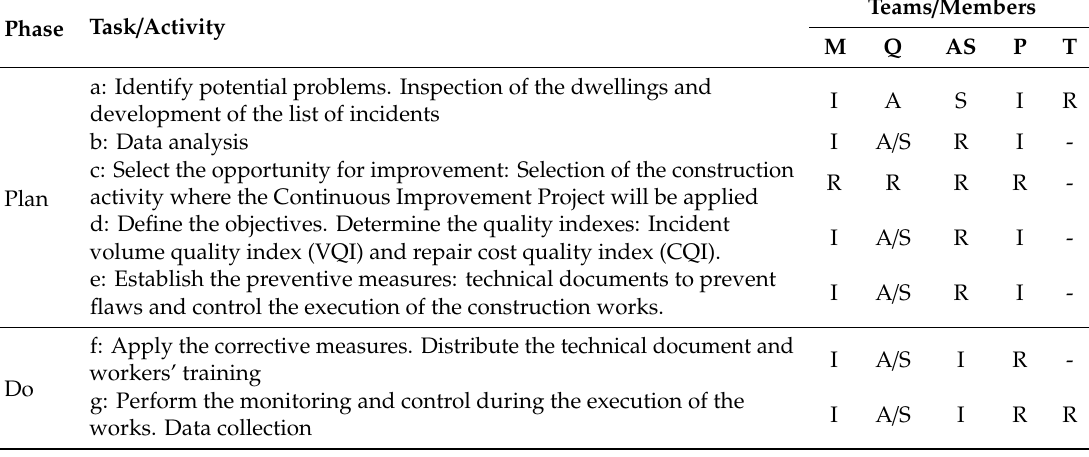
Table 1. Responsibility allocation